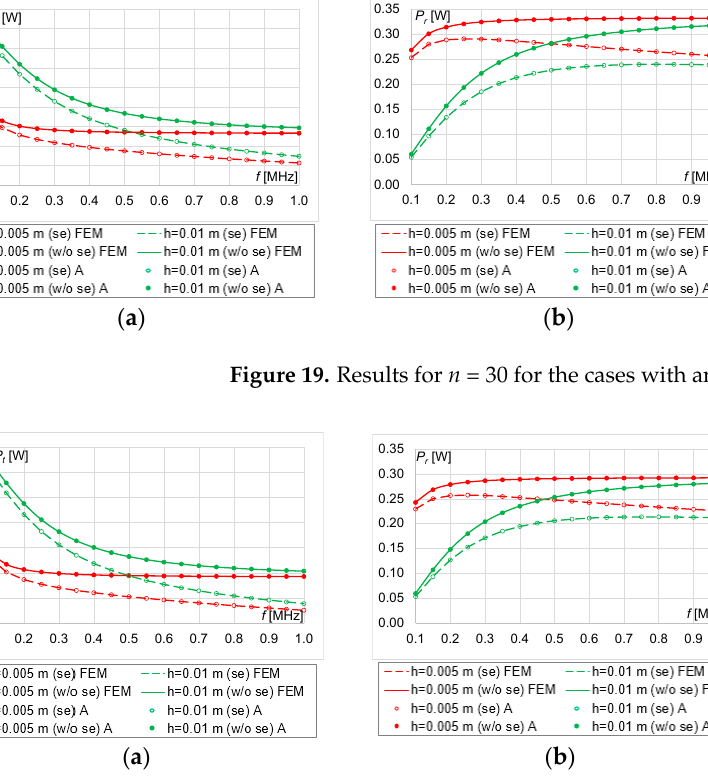
Figure 20. Results for n = 40 for the cases with and without skin effect: ( a ) P t , ( b ) P r , ( c ) η .